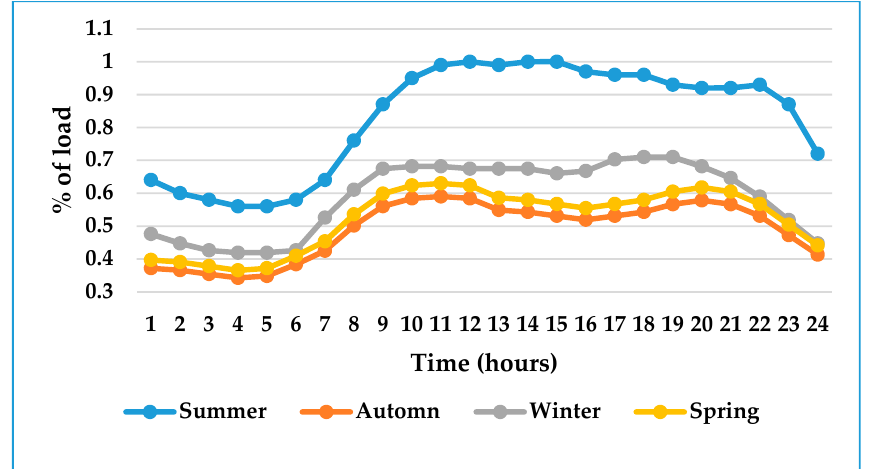
Figure 3. Seasonal time varying load profile values for each hour.